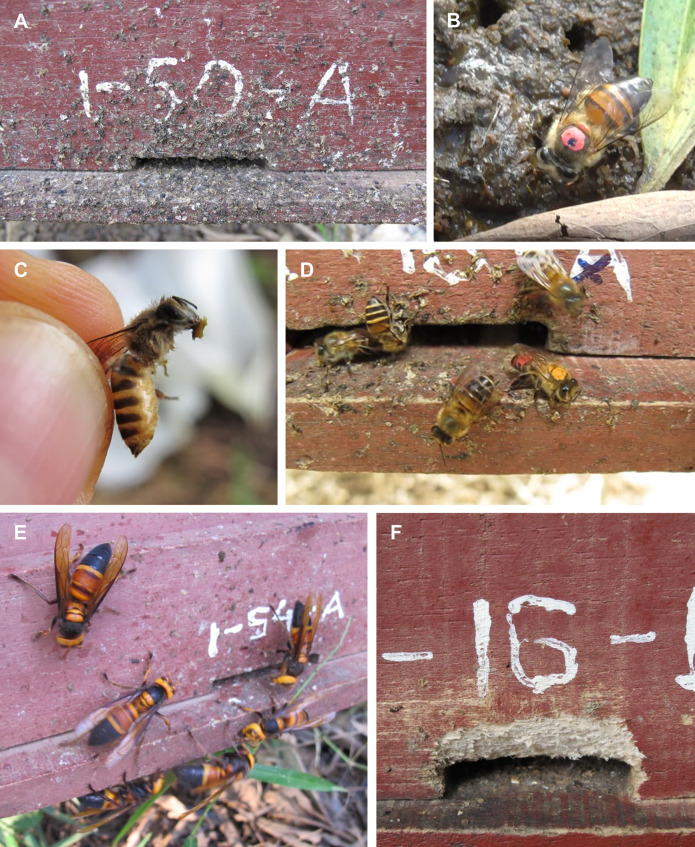
Apis cerana defended their colonies from group attack by Vespa soror by applying fecal spots around hive entrances.(A) A hive front with heavy fecal spotting around the entrance opening. (B) A marked A. cerana forager on a dung pile. (C) A forager holding a clump of fecal solids in her mandibles, captured after leaving a dung pile. (D) A forager applying a fecal spot to a hive front after being paint marked on a dung pile. (E) An entrance-focused group attack on a colony by six V. soror workers. (F) Damage to a hive entrance after entrance margins were chewed on by V. soror workers (the attack was stopped by experimenters before the nest was breached).